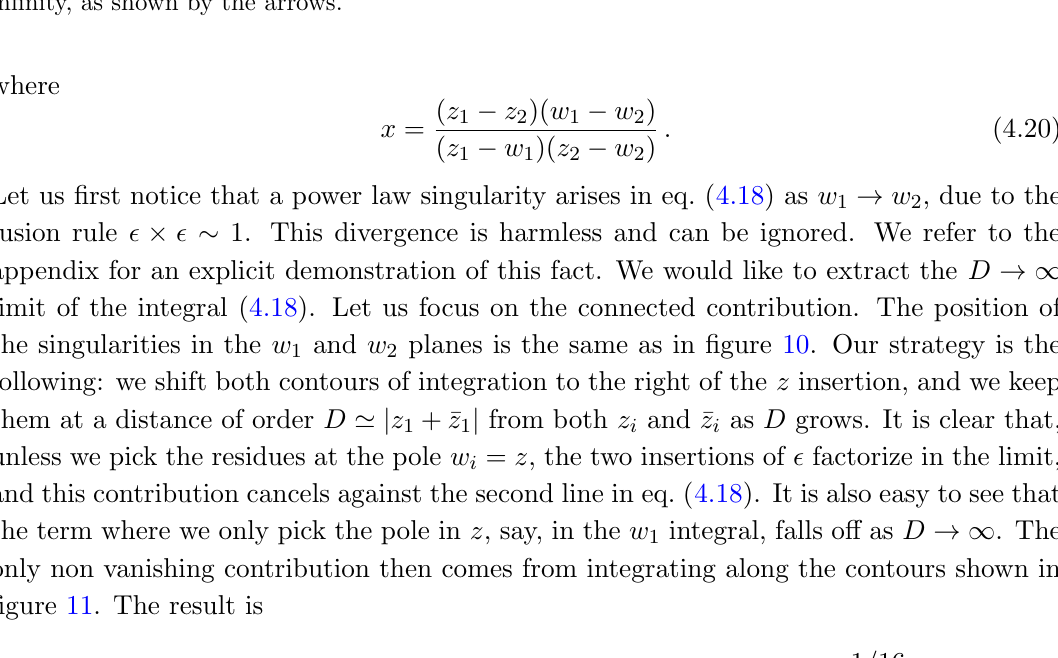
Figure 11 . The deformed contours of integrations in w 1 and w 2 which give a nonvanishing con- tribution to G 2 in the D ! 1 limit. The e(cid:11)ect of the limit is to carry the points (cid:0) (cid:22) z 1 and (cid:0) (cid:22) z 2 to in(cid:12)nity, as shown by the